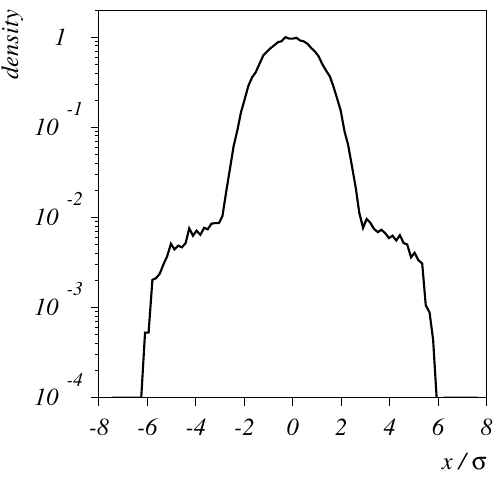
FIG. 7. Particle density profile normalized to the bunch cen- (cid:2) 6 : 26 (radial units in initial ter density in simulation for Q x (cid:1) ). Note the evolution of tails beyond 3 (cid:1) .